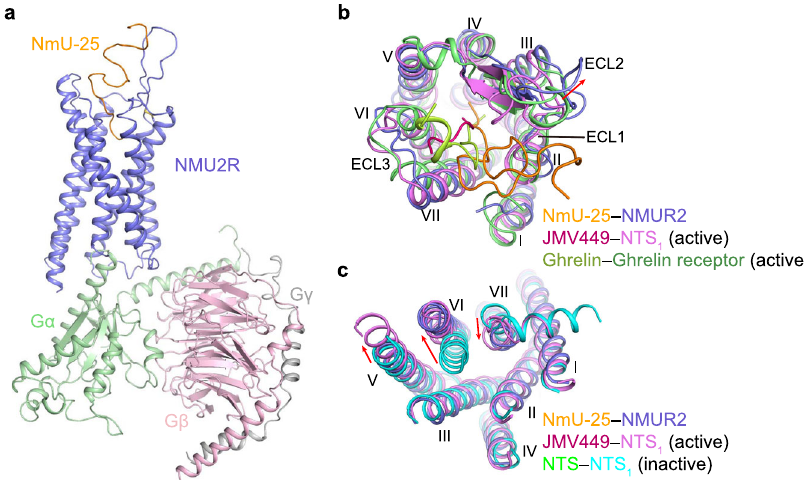
Fig.1|OverallstructureoftheNmU-25 – NMU2 – G i1 complex.a Cryo-EMstructure of the NmU-25 – NMU2 – G i1 complex is shown in cartoon representation. NmU-25, NMU2, G α , G β , and G γ are colored orange, slate, light green, light pink, and gray, respectively. The disul fi de bond is shown as yellow sticks. b Comparison of the ligand-bindingpocketinthestructureofNmU-25 – NMU2andotherpeptide-bound receptors.NTS 1 (PDBID:6OS9)andghrelinreceptor(PDBID:7F9Y)arerepresented